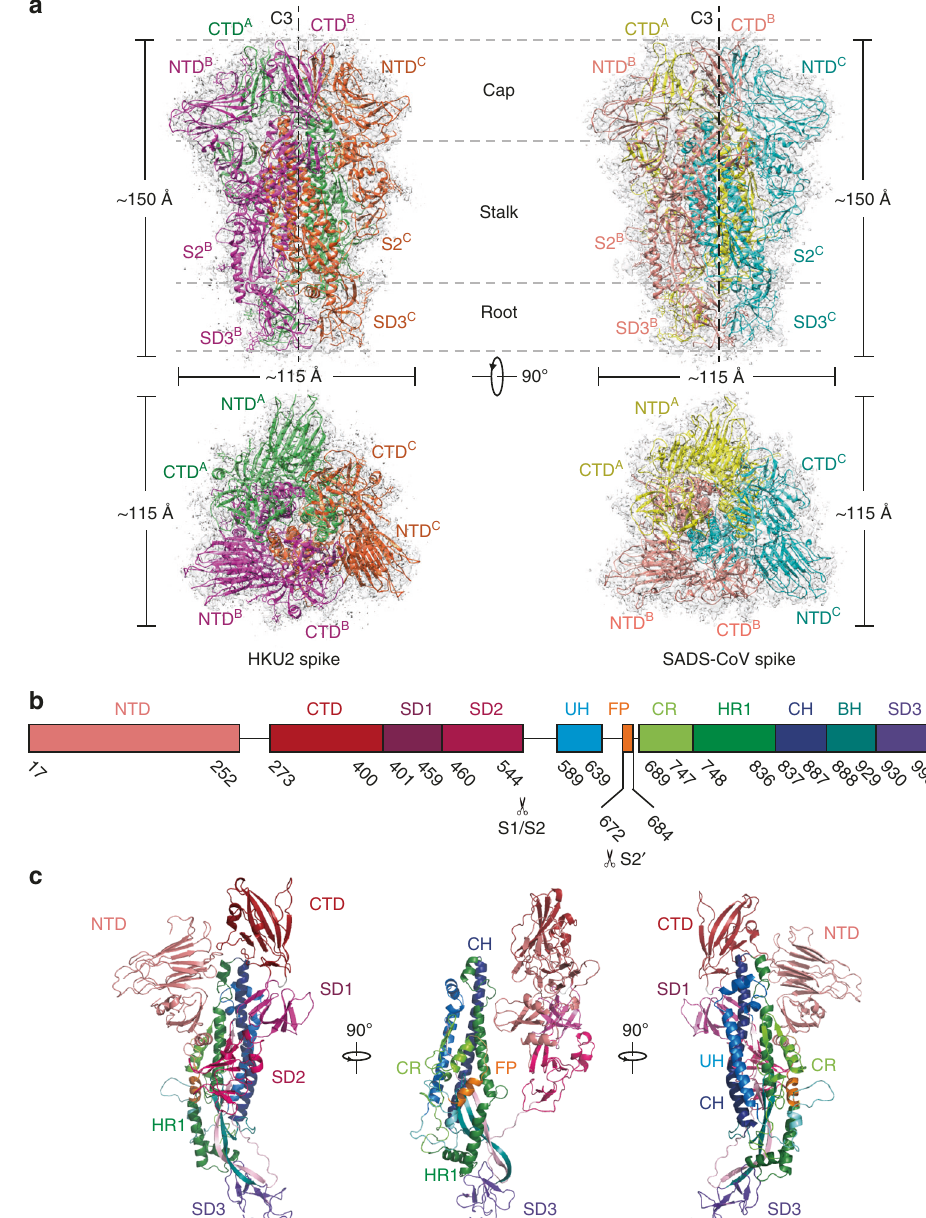
Fig. 1 Overall structures of HKU2 and SADS-CoV spike glycoproteins. a Overall structures of HKU2 and SADS-CoV spike glycoproteins shown in side view (upper panel) and top view (lower panel). Three monomers of HKU2 spike are colored magenta, green, and orange, respectively; three monomers of SADS-CoV spike are colored pink, yellow, and cyan, respectively. The cryo-EM maps are shown as semitransparent surface and contoured at 2.6 RMS and 3 RMS for HKU2 and SADS-CoV spikes, respectively. The trigonal axes are shown as black dashed lines. Visible segments of each monomer are labeled accordingly. The cap, stalk, and root parts are partitioned by gray dashed lines. b Segmentation of HKU2 monomer. The segments of HKU2 are shown as boxes with the width related to the length of amino acid sequence. The start and end amino acids of each segment are labeled. The position of S1/S2, and S2 ′ cleavage sites are indicated. NTD N-terminal domain, CTD C-terminal domain, SD1 subdomain 1, SD2 subdomain 2, UH upstream helix, FP fusion peptide, CR connecting region, HR1 heptad repeat 1, CH central helix, BH β -hairpin, SD3 subdomain 3. c Overall structure of HKU2 monomer. Side views of HKU2 monomer shown in three directions. The segments are colored the same as in b